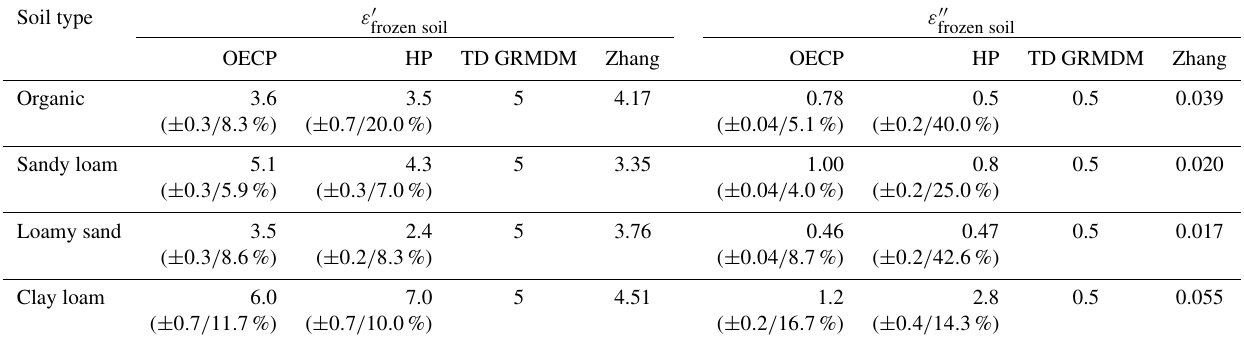
Table 3. Same as Table 2 but for frozen conditions ( − 5 to − 6 ◦ C). Soil type